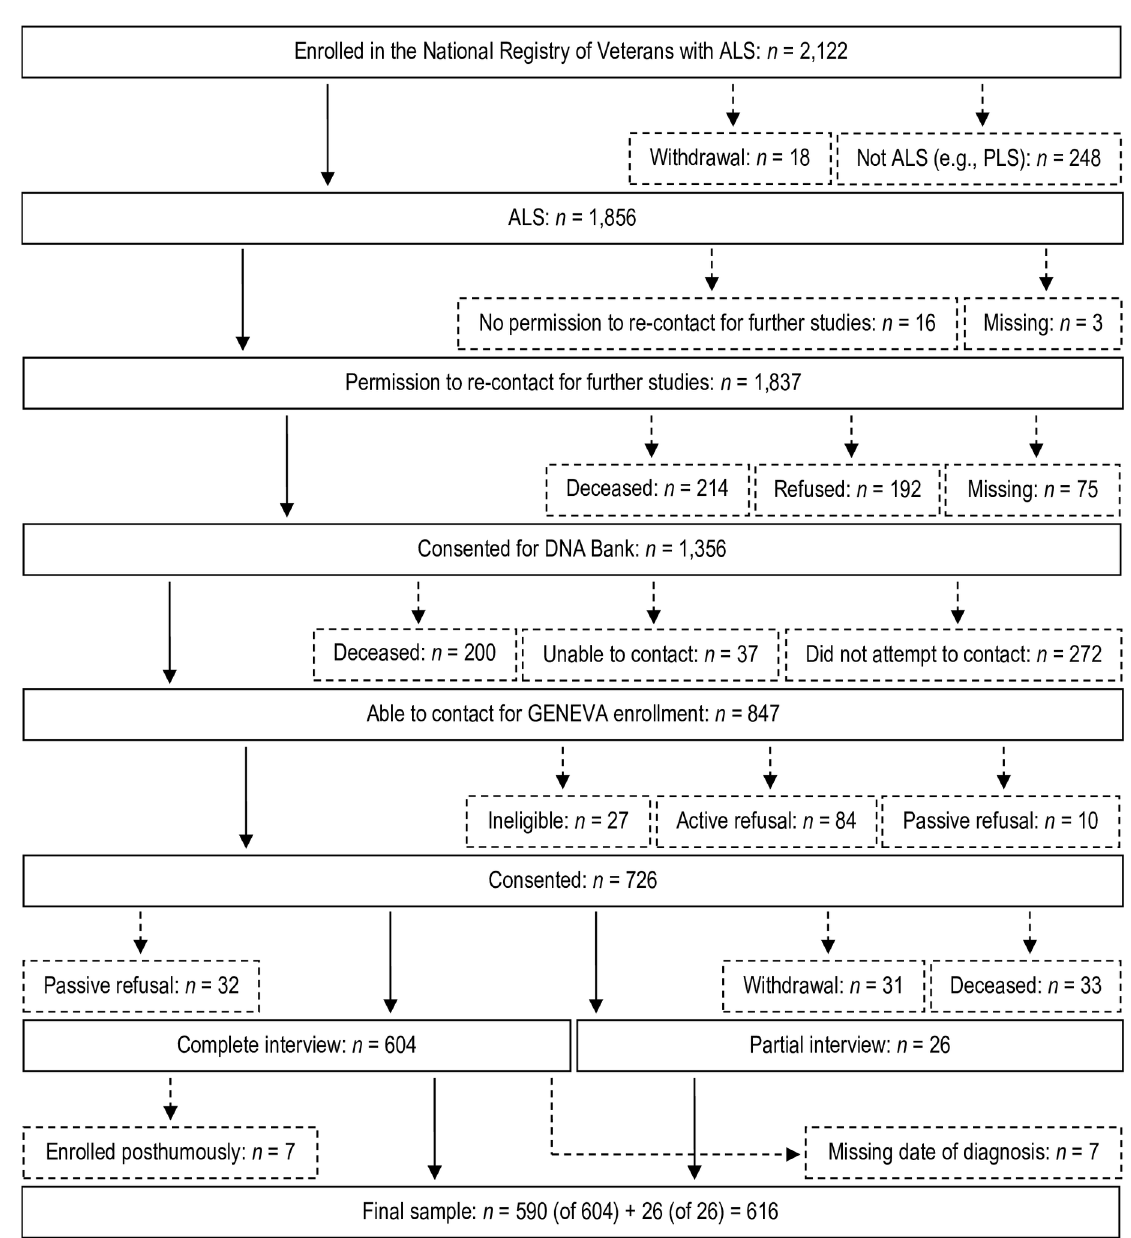
Fig 1. Flow chart showing the ascertainment of GENEVA cases, United States of America, 2005–2010. Solid boxes or lines depict cases who progressedpast each step shown. Small-dashed boxes or lines depict cases who did not progresspast each step shown, but who were incorporated into the analysisindirectlyvia inverseprobabilityweights (see Statistical Analysesand Section C in S1 File for more details). Among the 27 cases ineligiblefor GENEVA, reasonsincludeddementia(n = 9), diagnosis change(n = 4), withdrawalfrom the Registry DNA bank (n = 3), or interviewinfeasibility(n = 11). Abbreviations: ALS, amyotrophic lateral sclerosis; GENEVA, Genes and Environmental Exposures in Veterans with Amyotrophic Lateral Sclerosis study; PLS, primary lateral